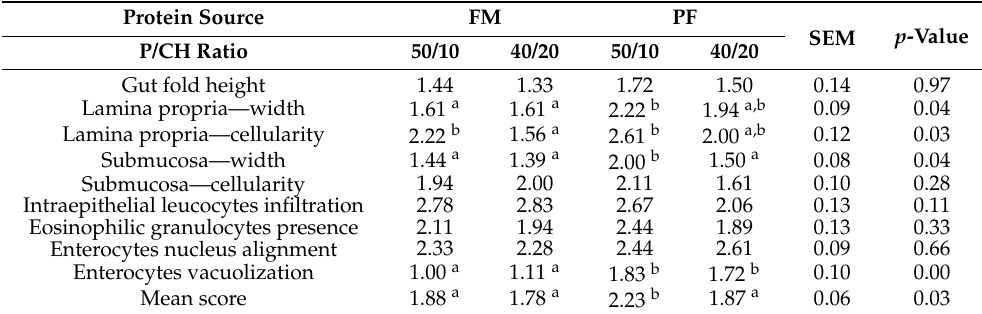
Values presented as means ( n = 9) and standard error of the mean (SEM). Different lower-case letters stand for statistical differences across dietary groups as determined by the Kruskal–Wallis all-pairwise comparisons.